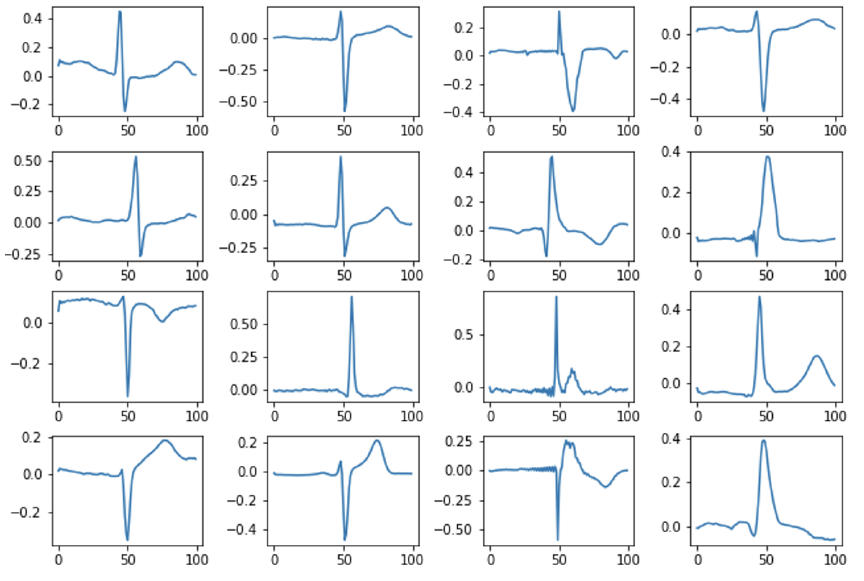
Figure 9. Example atoms of the DL